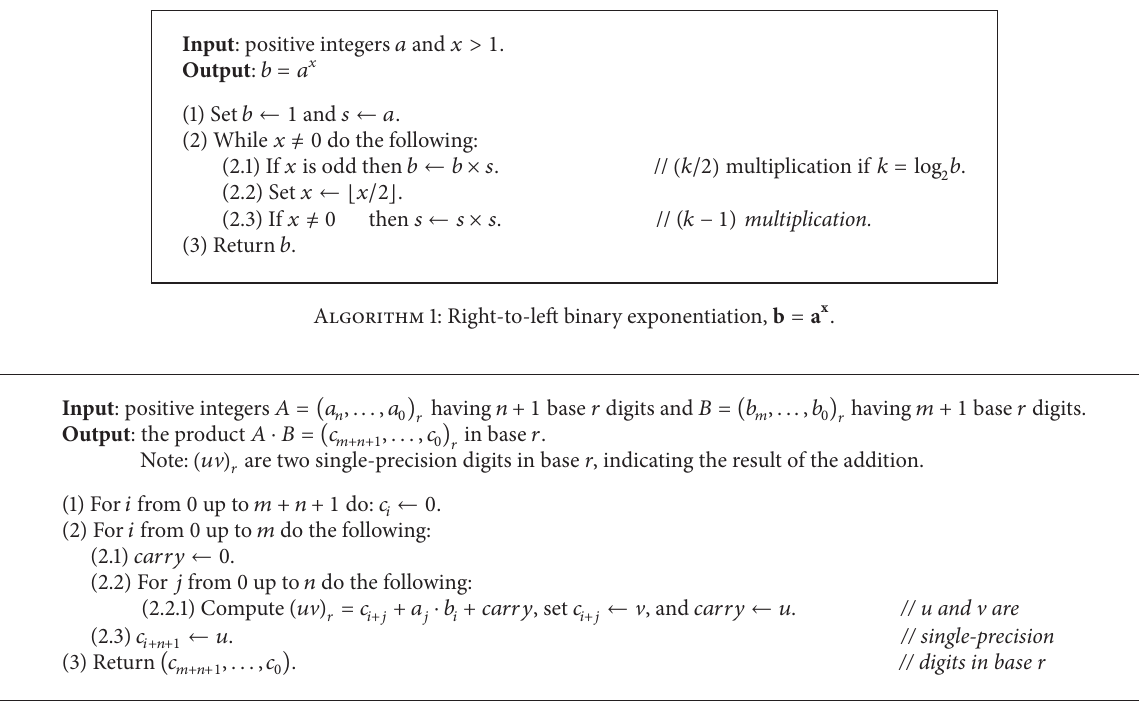
Algorithm 2: Multiple-precision classical multiplication, CM( 𝐴,𝐵